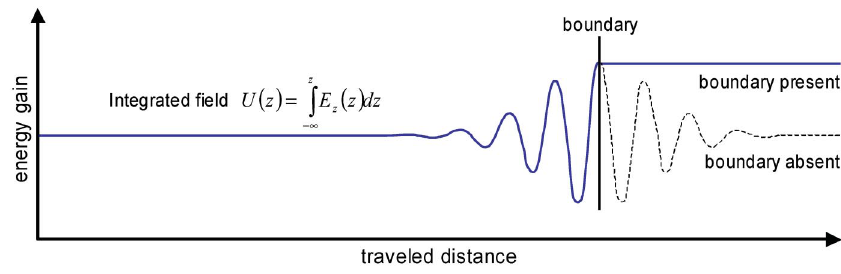
FIG. 2. (Color) Integrated field seen by a traveling electron along the z axis.